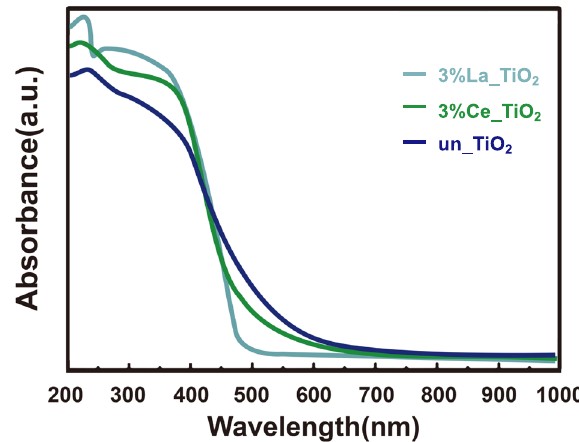
Fig. 5 UV – Vis absorption spectra of un_TiO 2 , 3%Ce-doped TiO 2 , and 3%La-doped TiO 2 . Ce/La-dopants may improve the photon utilization and enhance the photocatalytic activity of nano-TiO 2 .